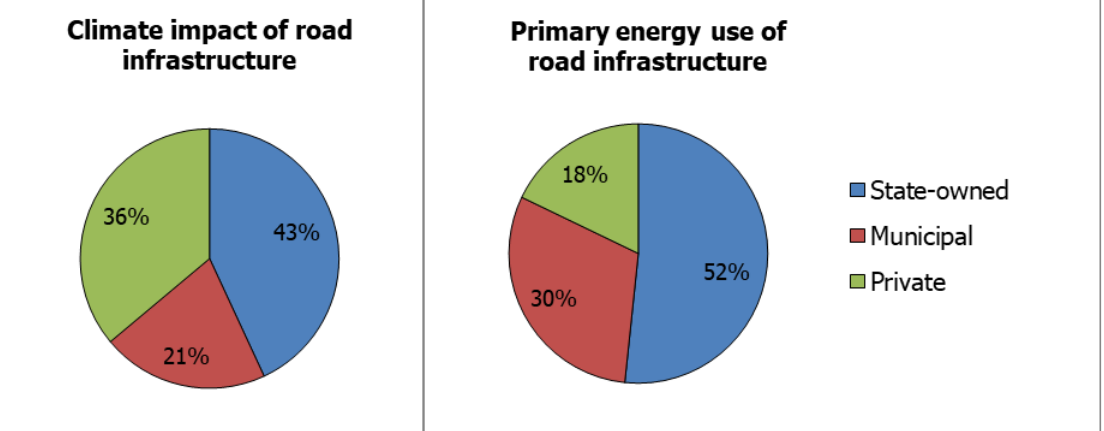
primary energy use is lower.